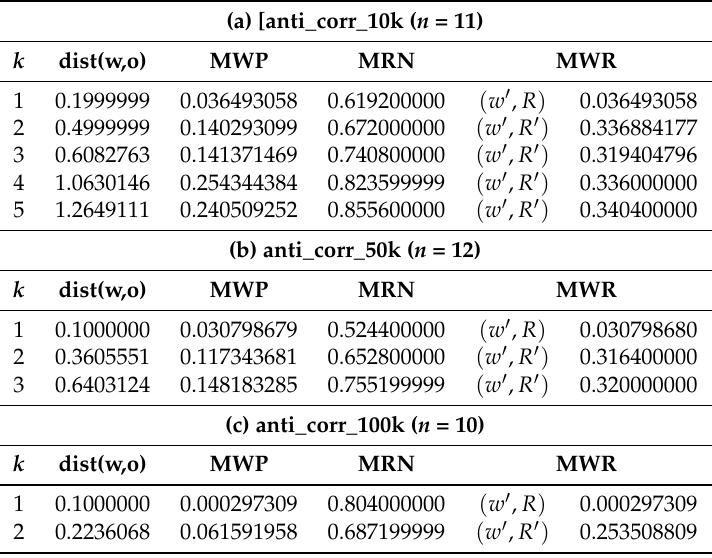
Table 3. Cost for anti-corr-data ( w ∈ R ).